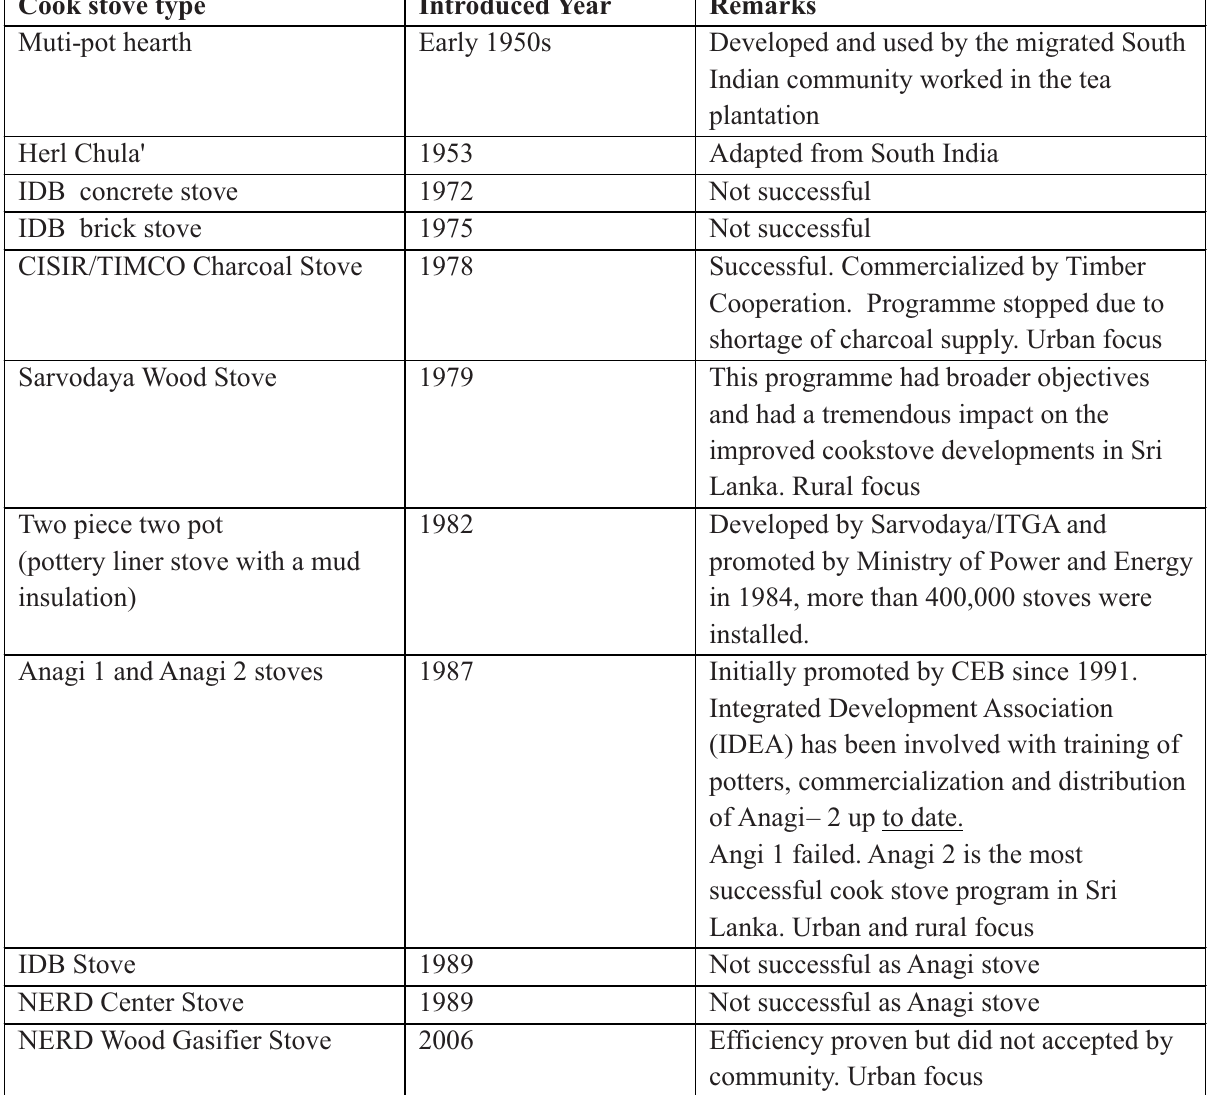
Table 4: Cook stove interventions in Sri Lanka Cook stove